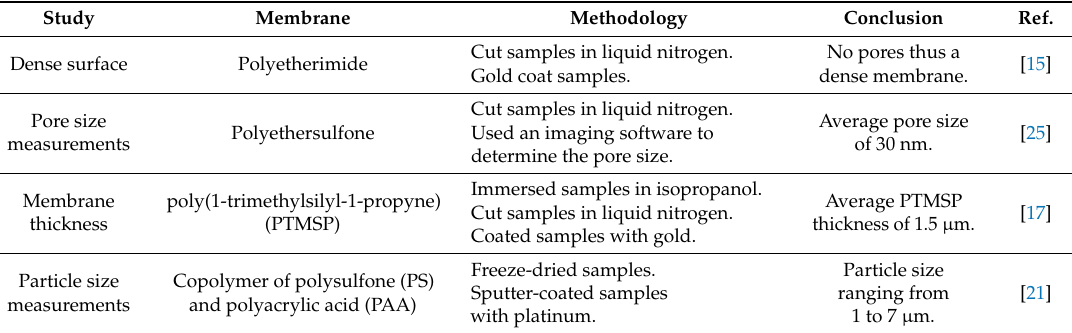
Table 1. Performed studies using SEM for characterization of polymeric